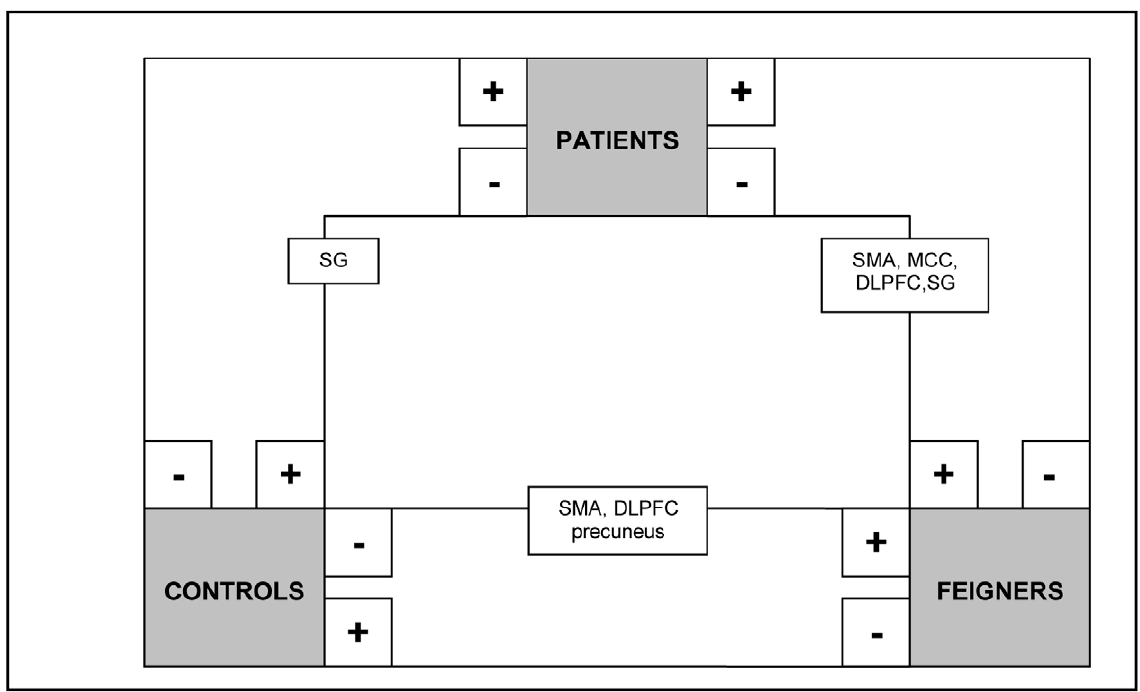
Figure 5. Schematic summary of significant clusters (P , 0.05, whole-brain corrected at cluster level; k . 200) in between-group comparisons (flipped data): movement imagery in the unaffected hand (analysis C). + =significantly more activated than -.